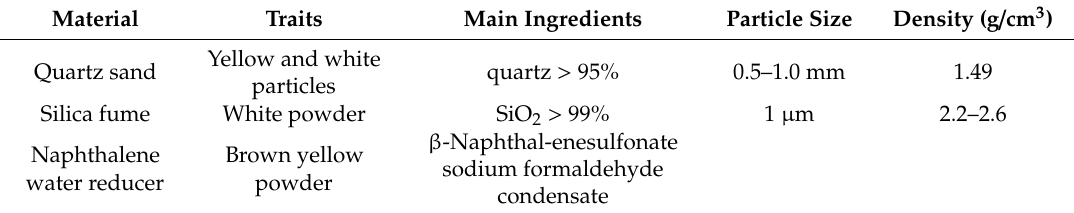
Table 2. Parameters of rock-like material.